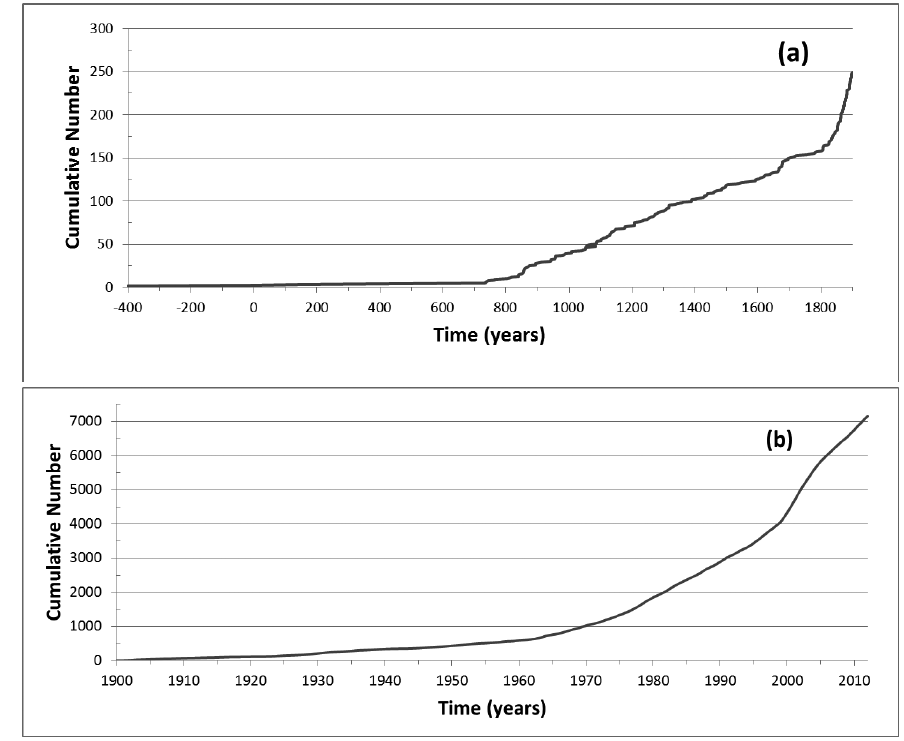
Figure 13. Cumulative numbers of historical (a) and instrumental (b) earthquakes versus